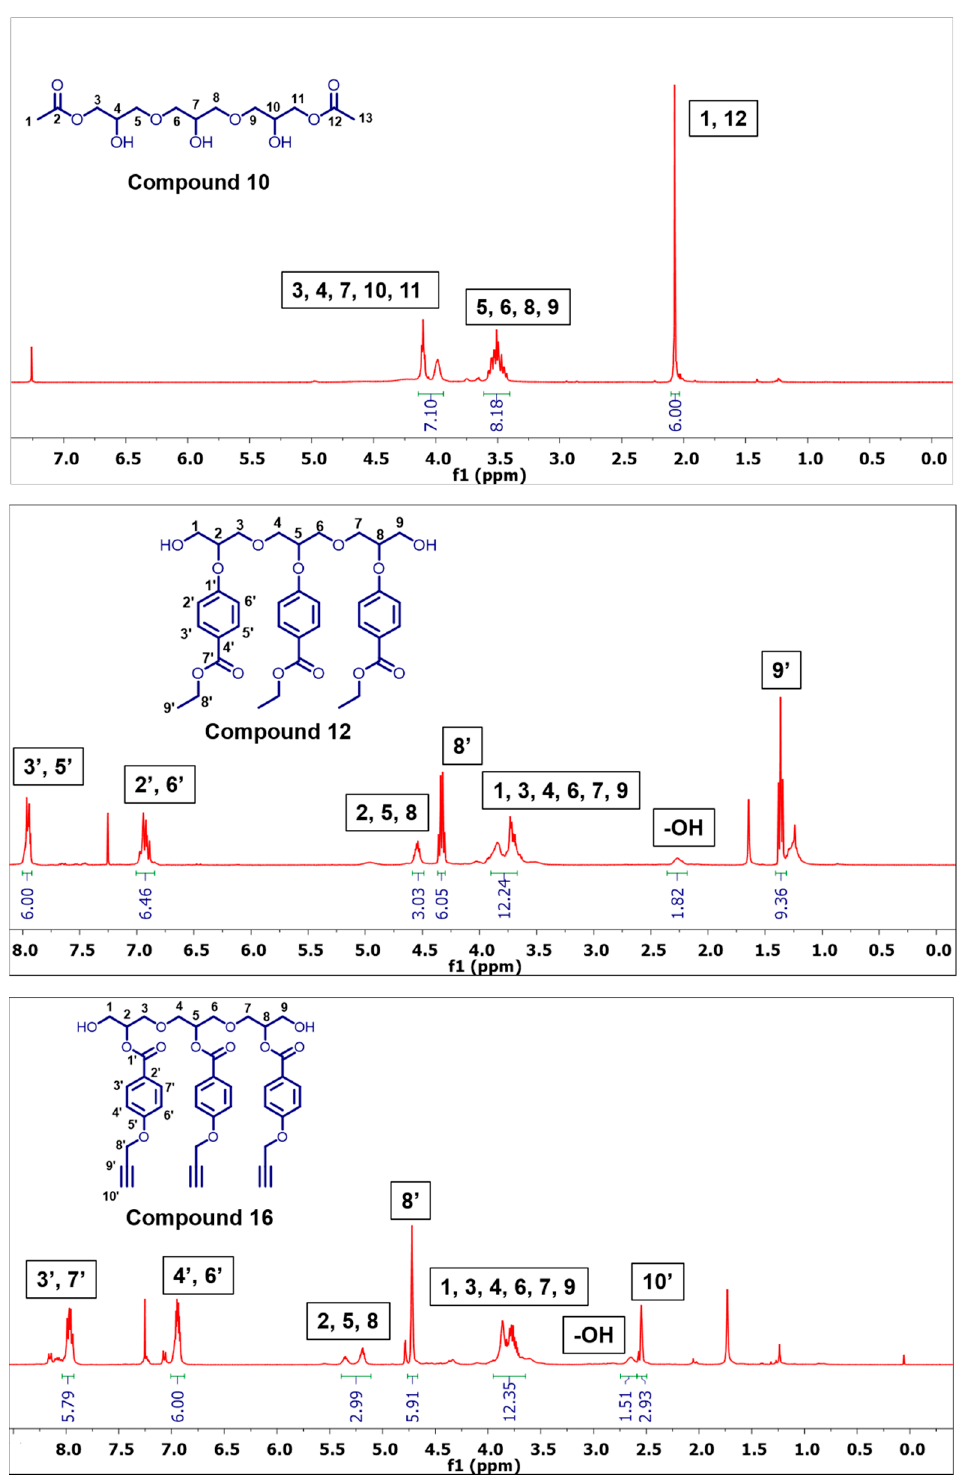
Figure 2. 1 H-NMR spectrum of compound 10 , 12 and 16 .